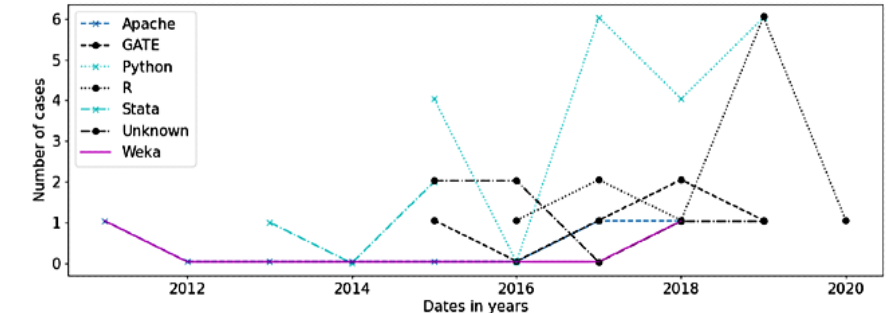
Figure 1. Platforms usage.